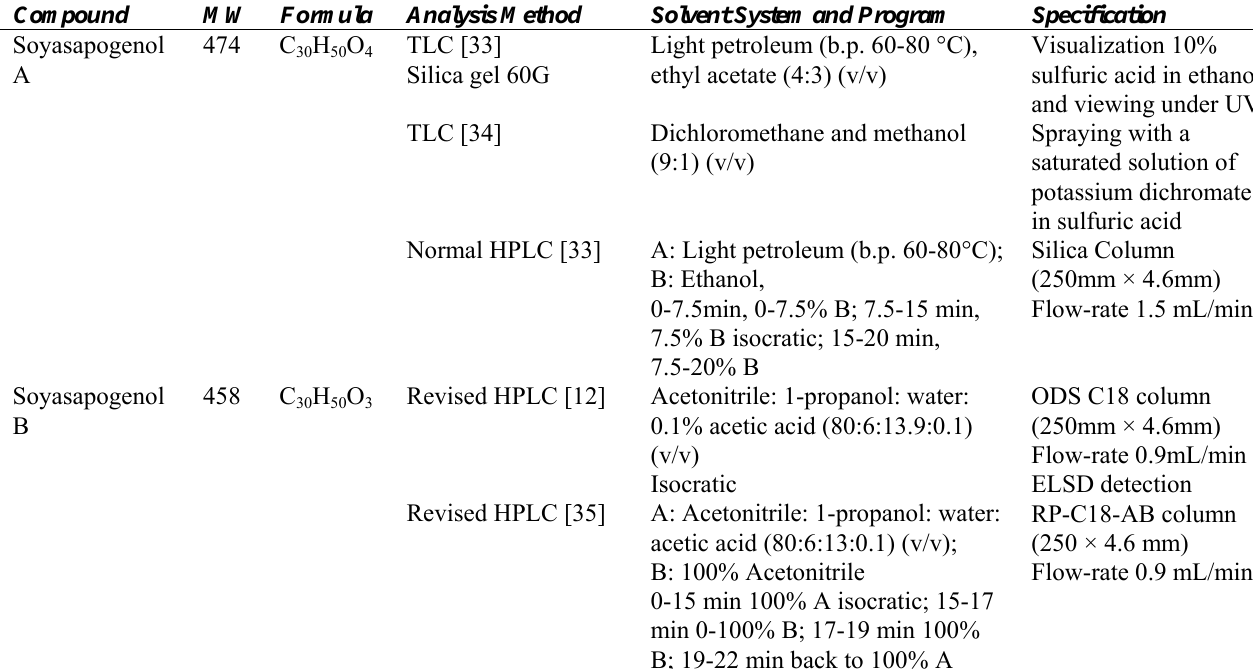
Table 2. Quantification Methods for Soyasapogenol A and